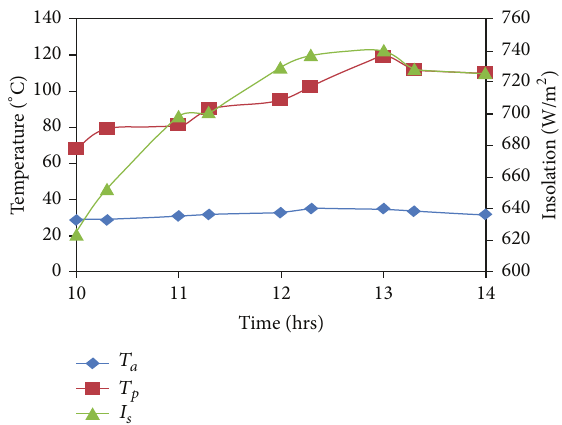
Figure 2: Stagnation temperature test of solar cooker for first figure of merit ( 𝐹 1 ) (03/03/2013).